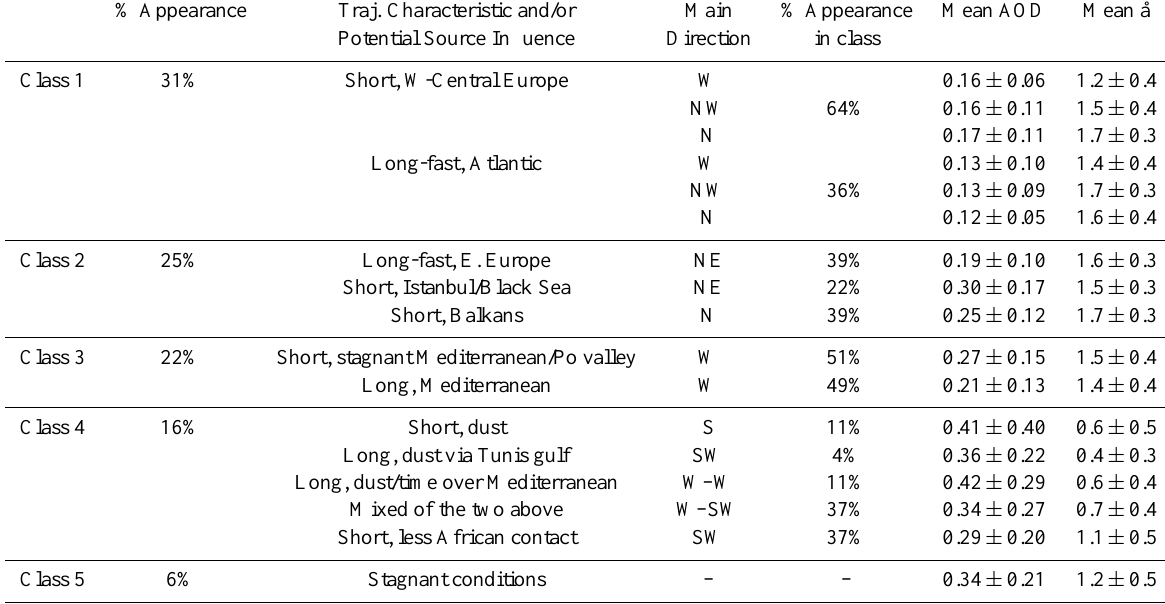
Table 2. Mean AOD and ˚Angstr¨om coefficient (˚a) per trajectories cluster. % Appearance Traj. Characteristic